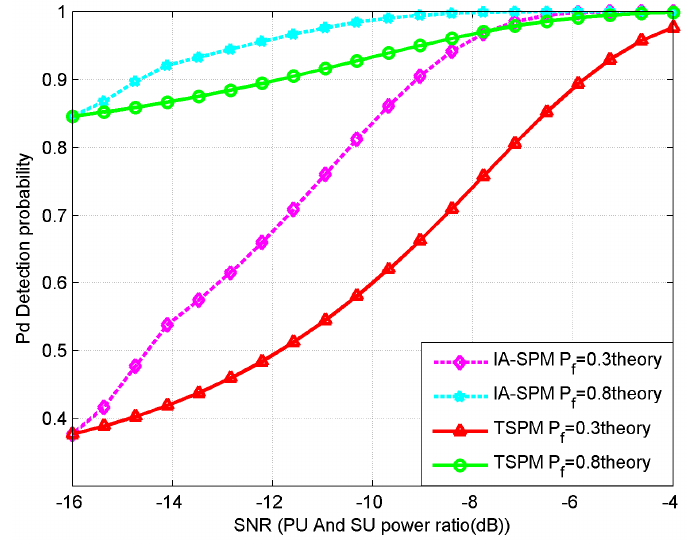
Figure 6. Comparison of the IA-SPM vs. the TSPM with different false dismissal probabilities.